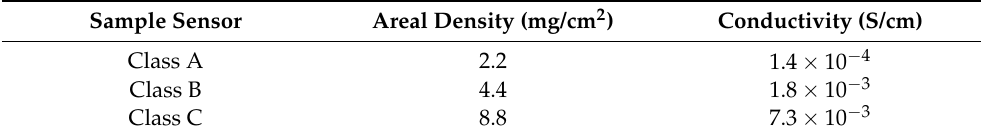
Table 1. Sensors based on Fe NWs with different areal densities.